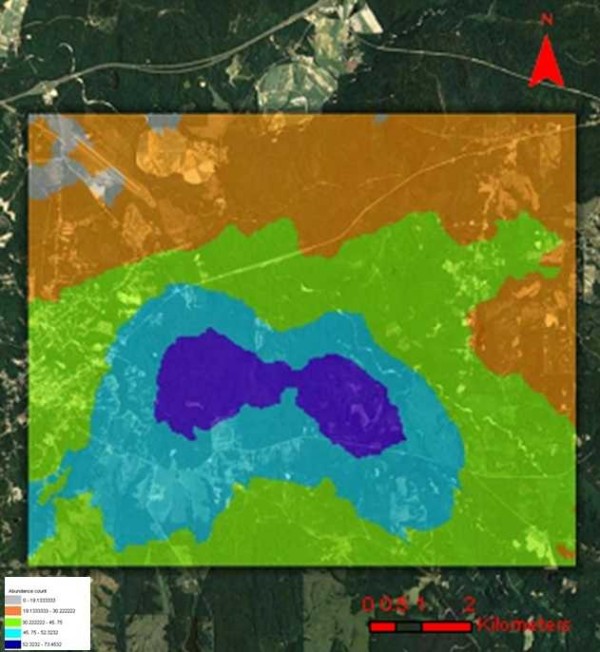
Predicted Culex erracticus abundance data using ordinary kriged model overlaid on a QuickBird visible and near infra-red (NIR) data of the Tuskegee study site.